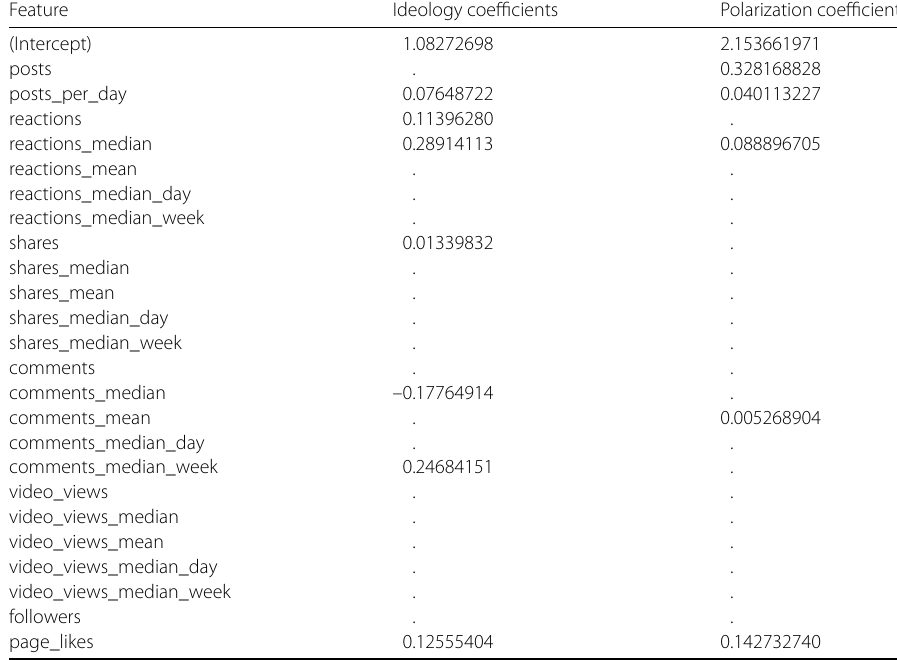
Table 8 Lasso Regression coefficients